Question: Write the caption for this figure.
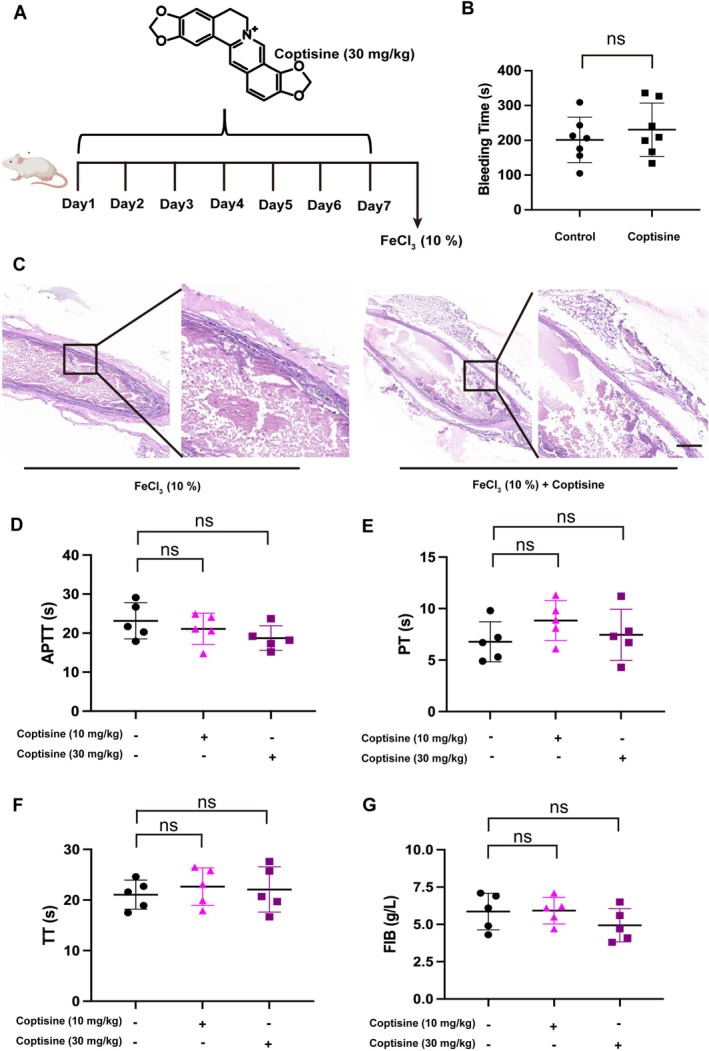
Answer: Coptisine inhibits thrombus formation but has no significant impact on the coagulation system. (A) In vivo experimental design. (B) Mice were orally administered coptisine (30 mg/kg) or vehicle control. The distal 2 mm of the tail was surgically excised and immediately immersed in pre‐warmed 0.9% NaCl solution, and the bleeding cessation time was recorded. n = 7, ns = p > 0.05. (C) H&E staining images of carotid artery thrombi ( n = 3). (D–G) Effects of coptisine treatment on coagulation function indicators in rats: Prothrombin time (PT), activated partial thromboplastin time (APTT), thrombin time (TT), and fibrinogen (FIB) levels. Results are expressed as mean ± SD. n = 5, ns = p > 0.05. Scale bar represents 100 μm.